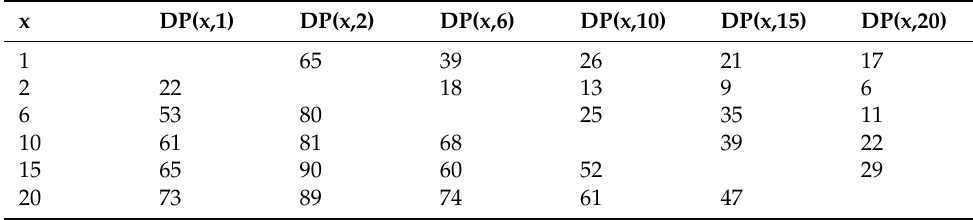
Table 3. Domination percentage metric for the Pareto solutions of different scenarios.